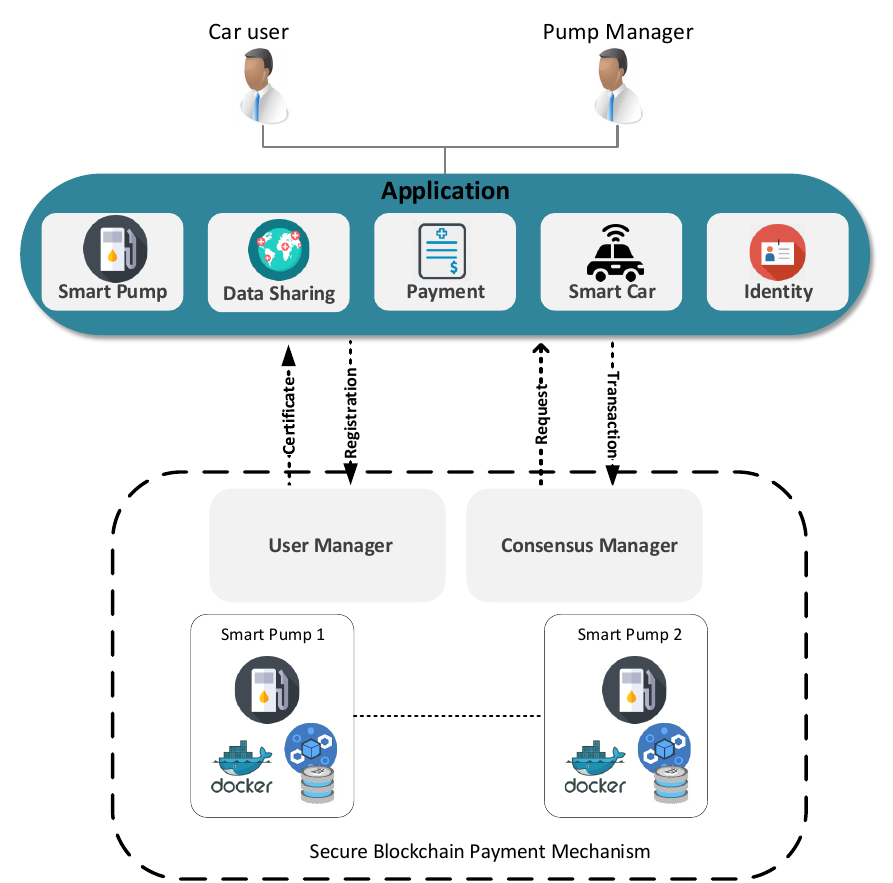
Figure 4. System architecture of proposed blockchain